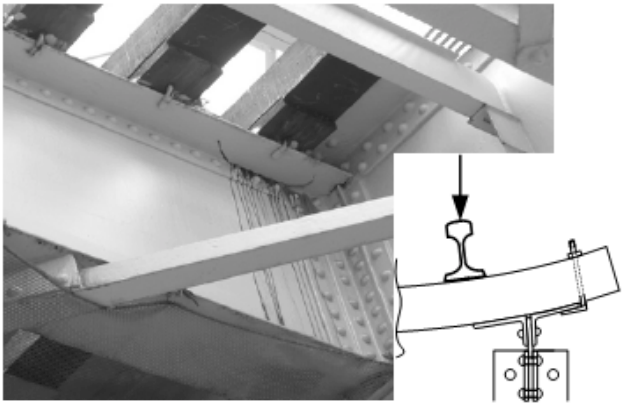
Figure 9. Example of fatigue cracking in stringers at timber tie connections [8].